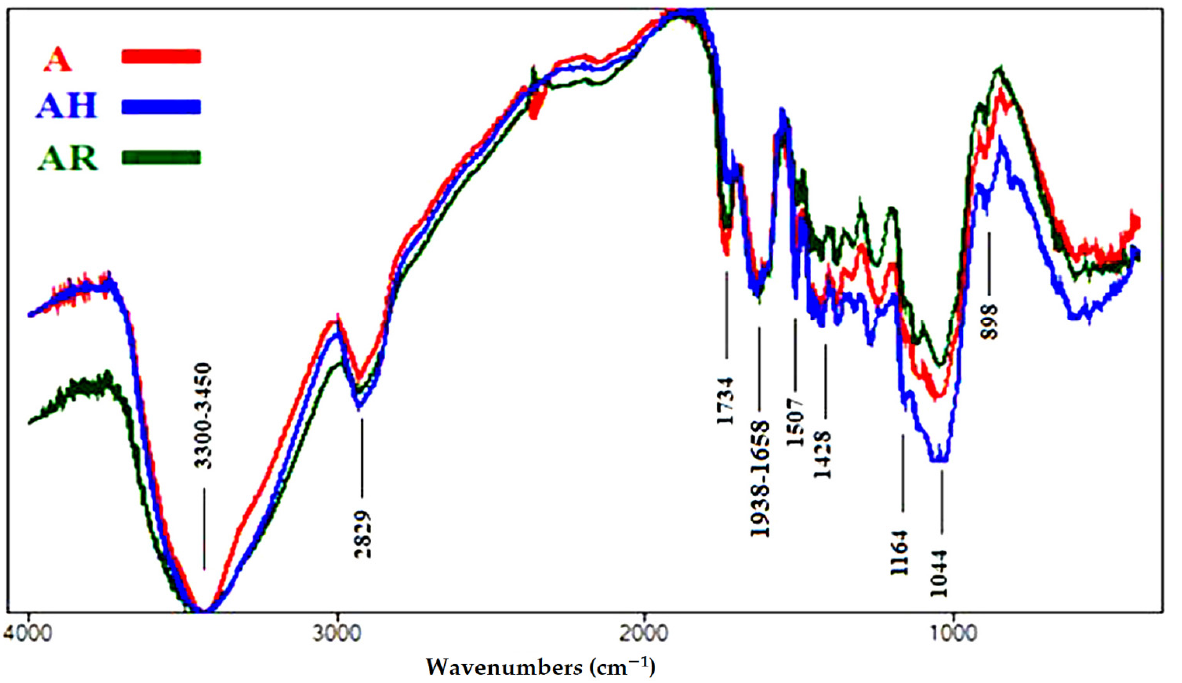
Polymers 2021 , 13 , x FOR PEER REVIEW